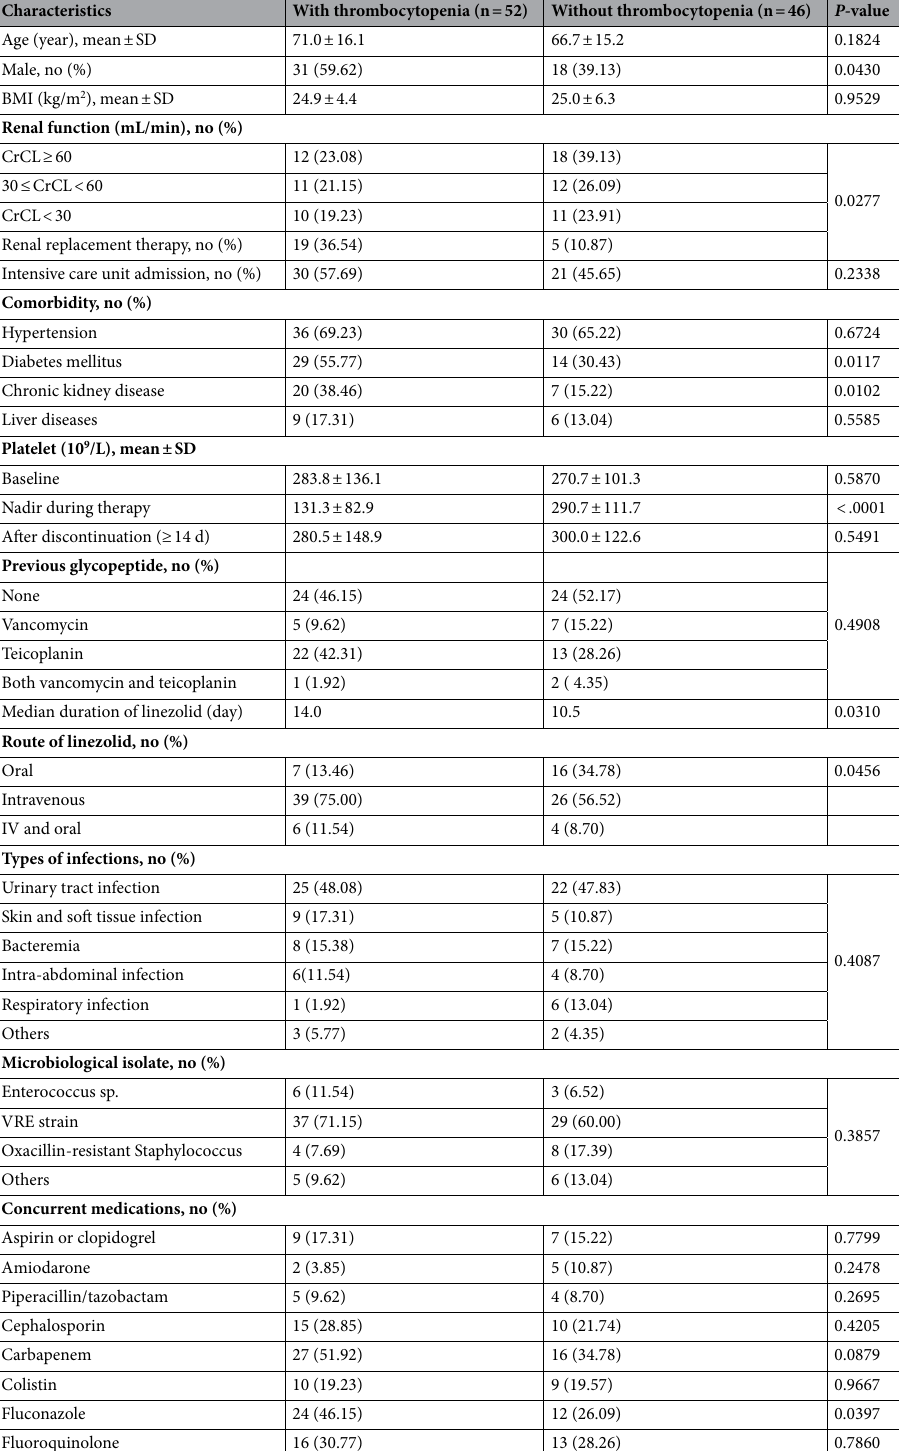
Table 1. Individual and characteristics data of enrolled patients. BMI, body mass index; CrCL, creatinine clearance; IV, intravenous; VRE, vancomycin-resistant enterococcus; SD, standard